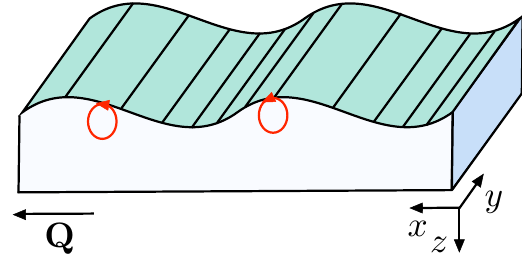
Figure 1: Rayleigh surface acoustic wave propagating with the wave vector Q parallel to the axis x . The axis z is the coordinate of the depth of the material. Atoms on the surface have elliptical trajectories, which is a combination of longitudinal and transverse modes [ 25 ]